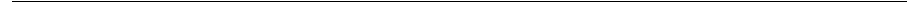
H 0 Model1 Model2; CFI Comparative Fit Index, TLI Tucker-Lewis =